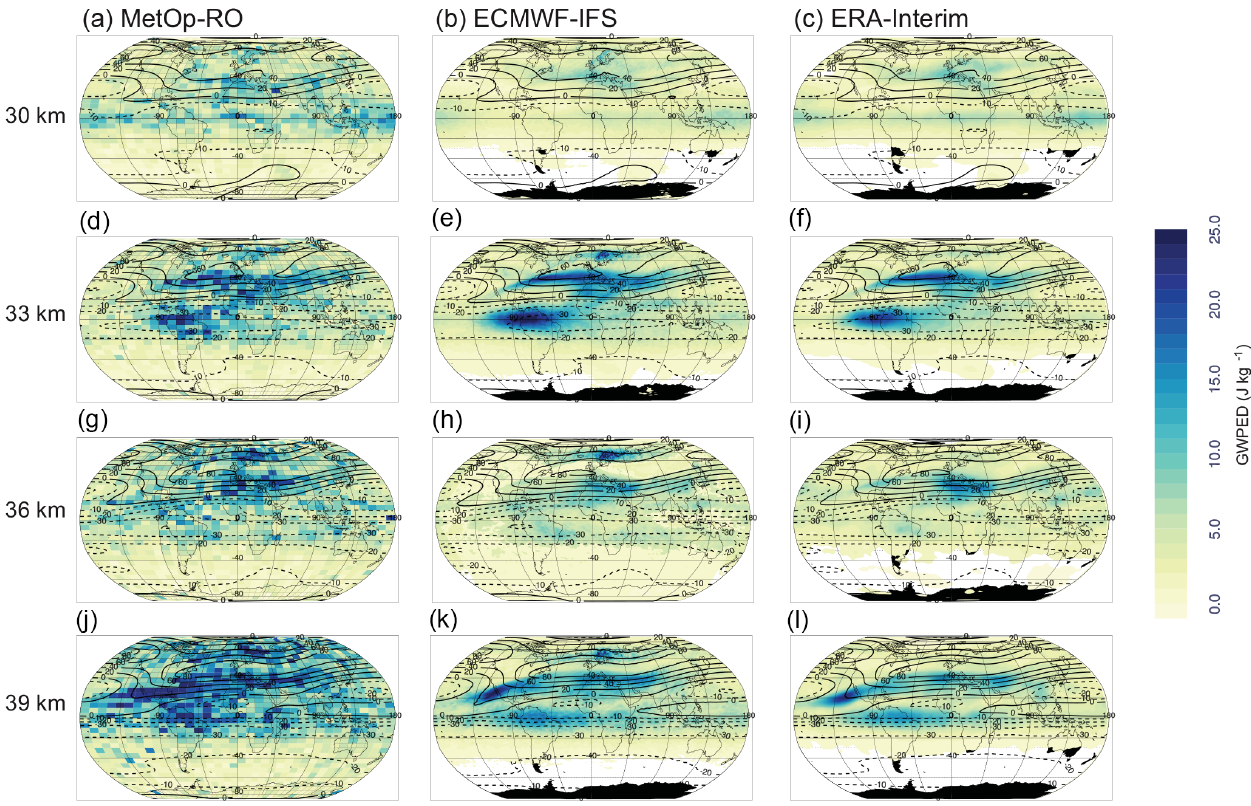
Figure 6. Monthly mean latitude–longitude cross sections of E P at selected altitudes of 30, 33, 36, and 39km (a–l) for December 2015. (a, d, g, j) METOP RO-dry data, (b, e, h, k) IFS data, and (c, f, i, l) ERA-Interim data. In all panels, black contour lines show zonal wind values from